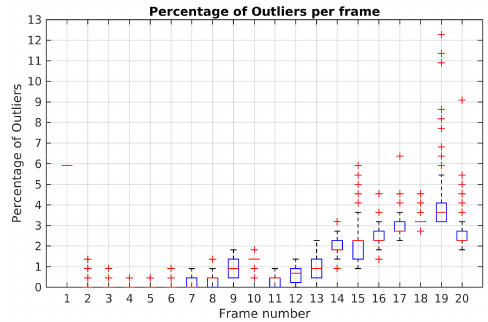
Figure 18. Outliers percentage in Monte-Carlo experiment for Scene 4 using